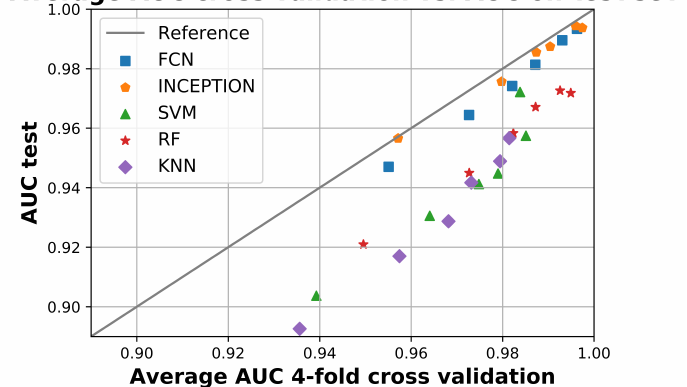
Figure 5. The figure shows the average area under the curve (AUC) during the 4-fold cross validation on the x-axis and the AUC when applied on the test set. All models below the reference line performed worse on the test set compared to training and vice versa. The figure shows that no model performed better on the test set compared to training, but the deep neural network model InceptionTime (INCEPTION) had the smallest overall difference. Figure created using Matplotlib